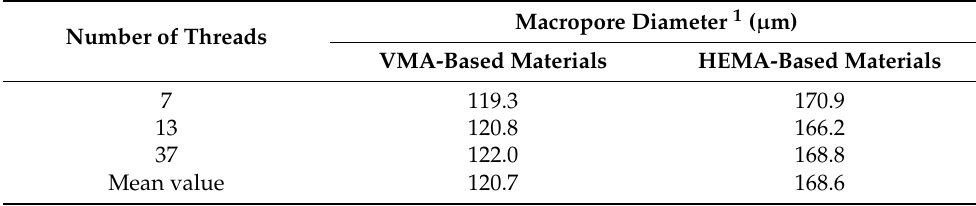
Table 3. Determination of average macropore diameter using Image J ® software (with a fixed nylon thread diameter of 120 µ m).